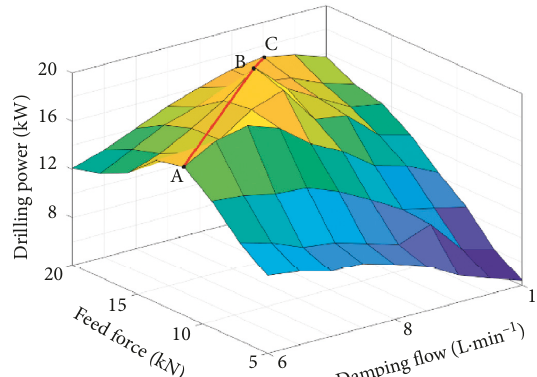
Figure 8: The comparisons of impact energy under different combinations ( Q d , F d ).